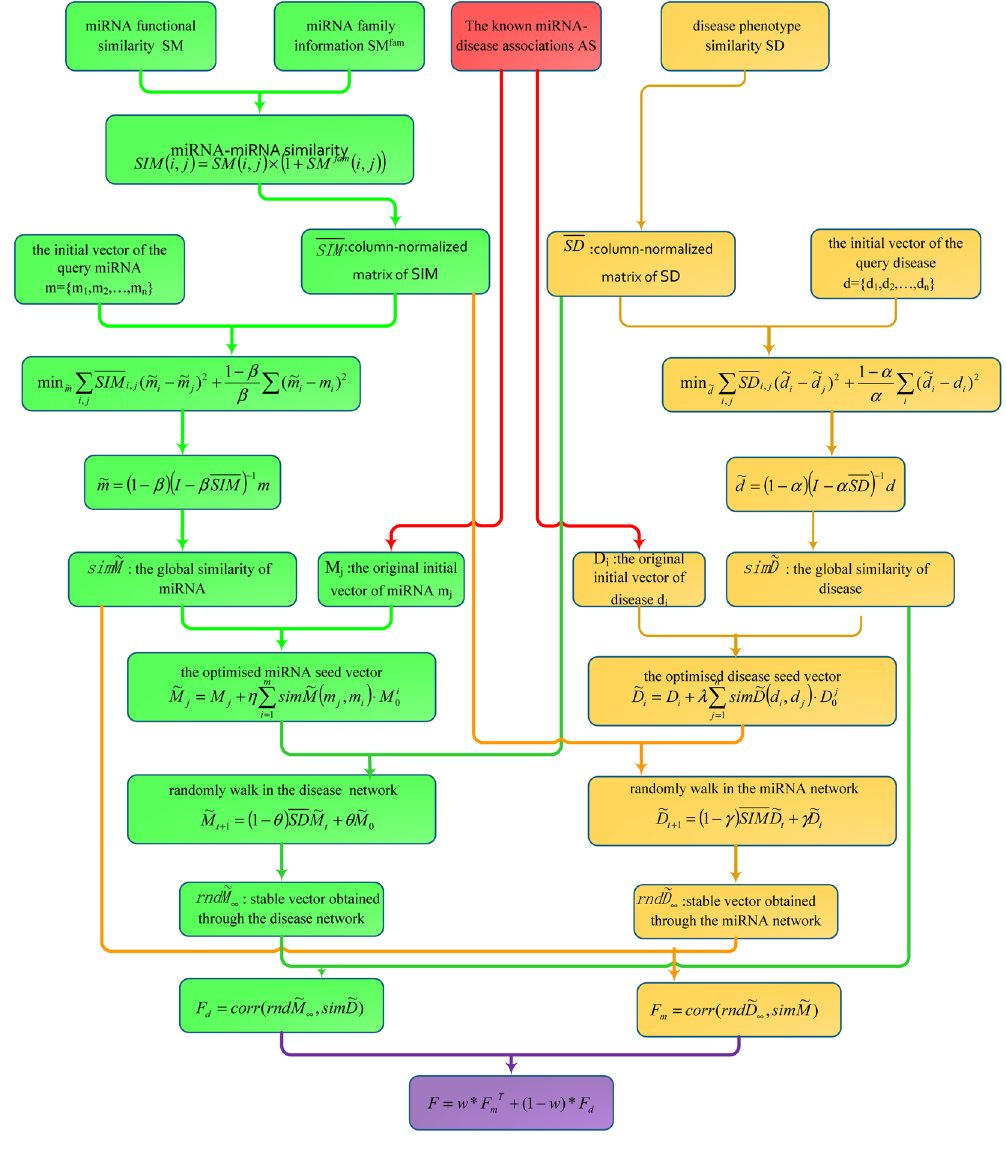
Figure 7. The overall flowchart of